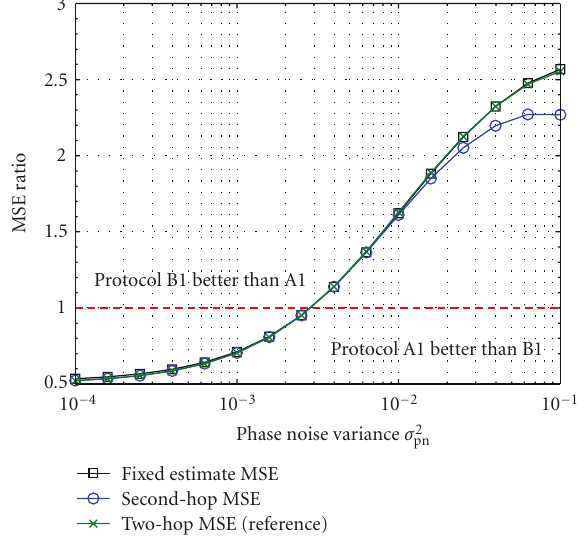
Figure 6: MSE ratios (see page 23) versus σ 2 and SNR est = 20dB.